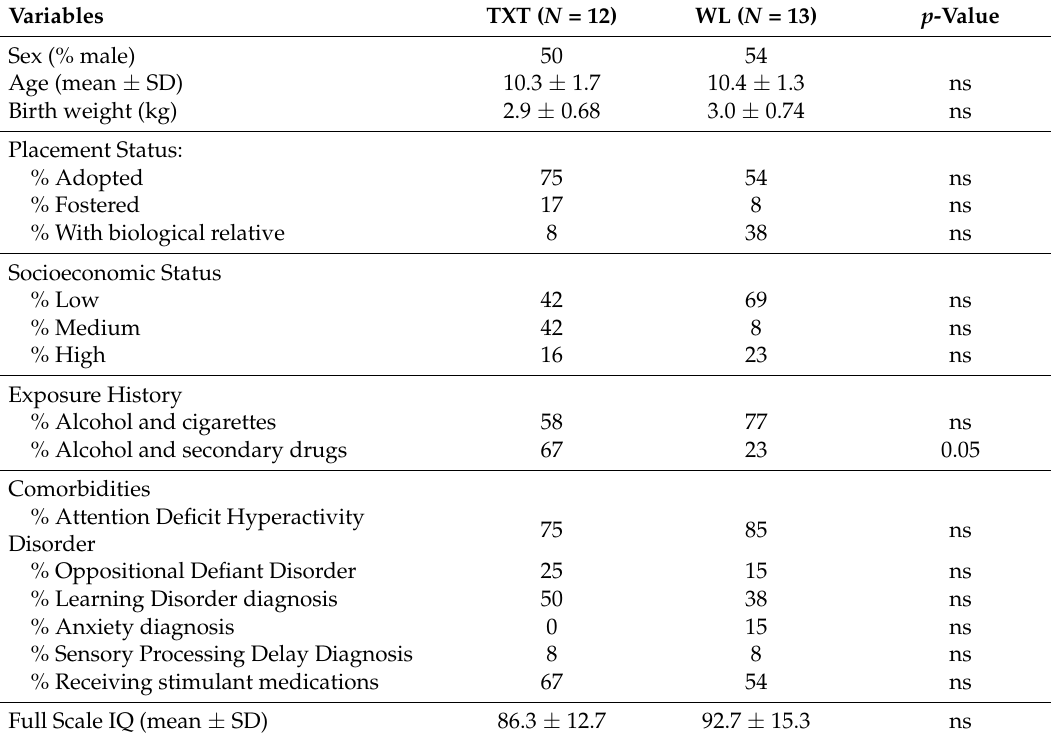
Table 1. Demographic characteristics of the Treatment (TXT) and Waitlist (WL)